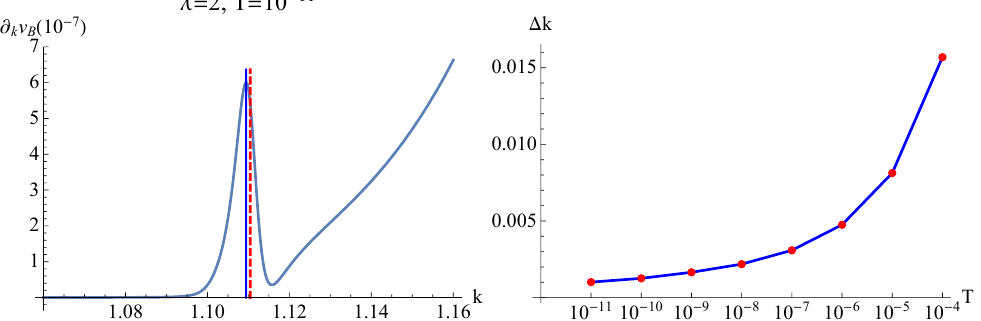
Figure 2 . v B v.s. k at di(cid:11)erent low temperatures T = 10 (cid:0) 4 ; 10 (cid:0) 5 ; 10 (cid:0) 9 ; 10 (cid:0) 11 respectively. In each plot the dotted line in red represents the location of QCP, separating the insulating phase (left side) and metallic phase (right side).